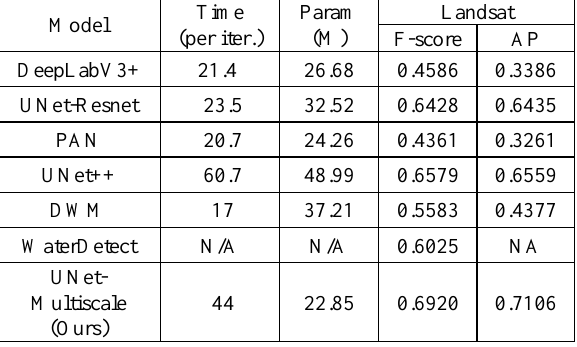
Table 1. Comparison of Water Contour Detection using our RGB dataset for Landsat.